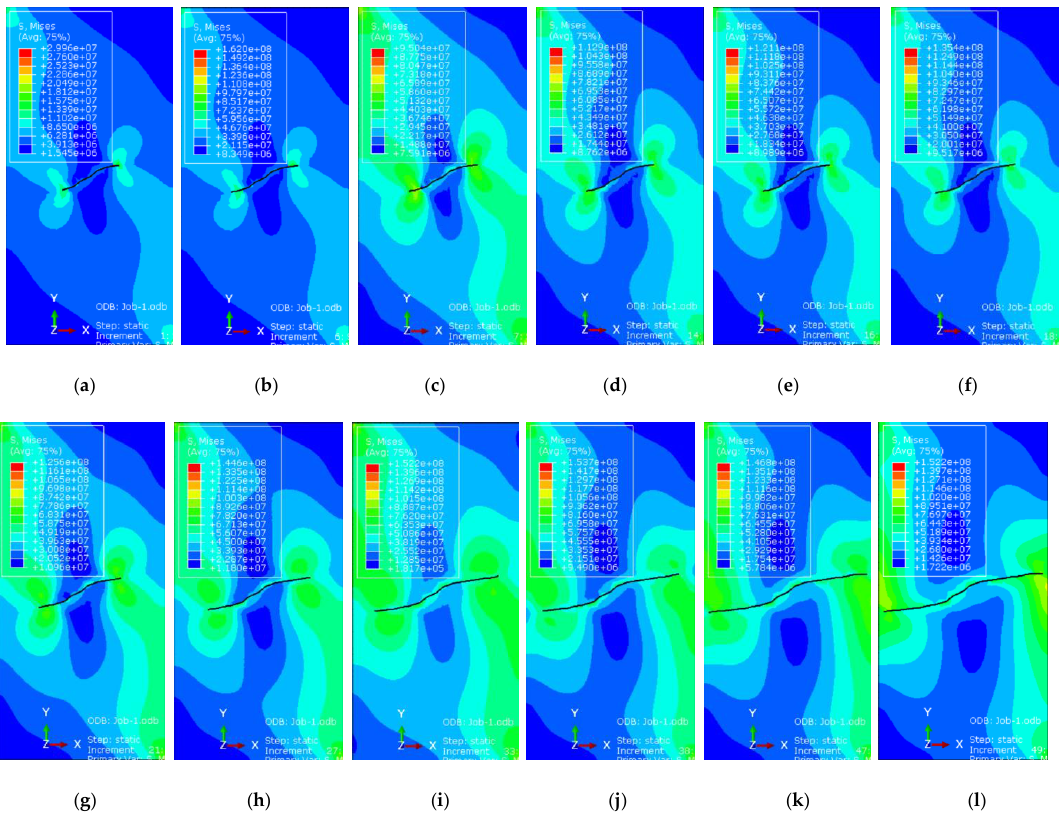
Figure 22. Dynamic evolution of fractal fractures in different time. ( a ) t = 0.01 s, ( b ) t = 0.05407s, ( c ) t = 0.5409 s, ( d ) t = 0.05526 s, ( e ) t = 0.05683 s, ( f ) t = 0.06034 s, ( g ) t = 0.07118 s, ( h ) t = 0.08267 s, ( i ) t = 0.08865 s, ( j ) t = 0.09205s, ( k ) t = 0.09370 s, ( l ) t = 0.09427 s.